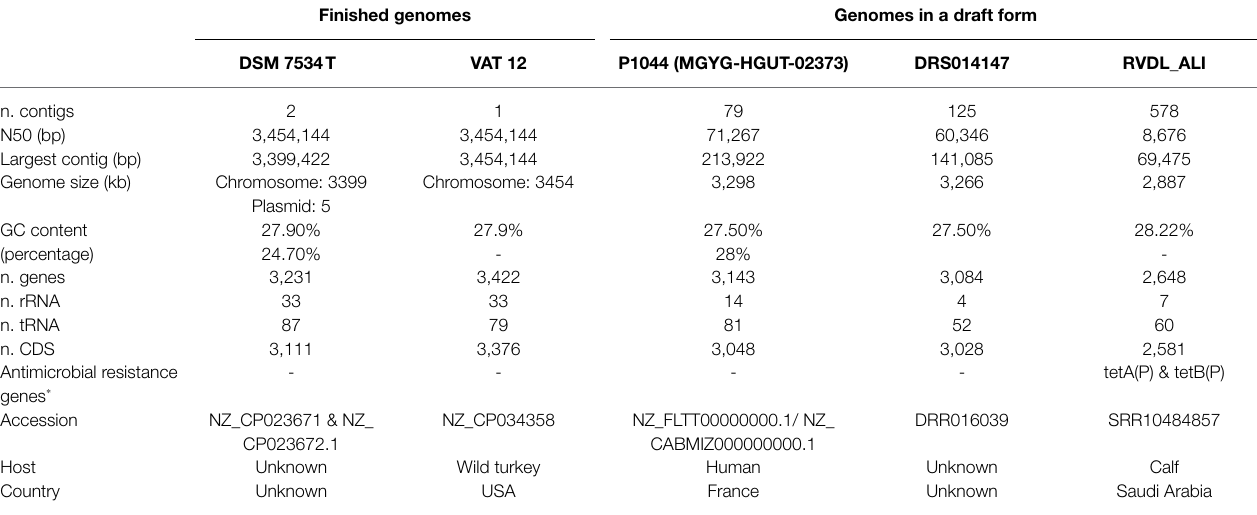
TABLE 2 | Genome assembly, annotation, and metadata